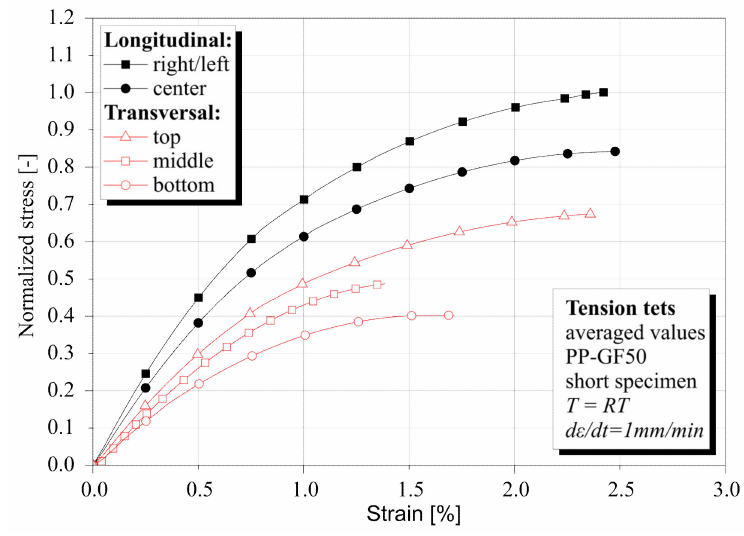
Figure 4. Averaged stress/strain-curves for quasi-static test results at all investigated positions.